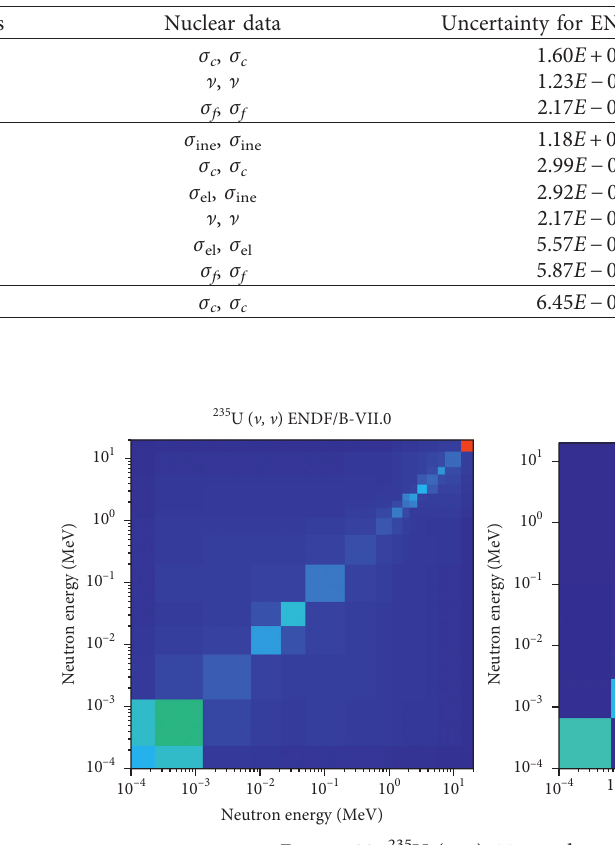
uncertainty. eff